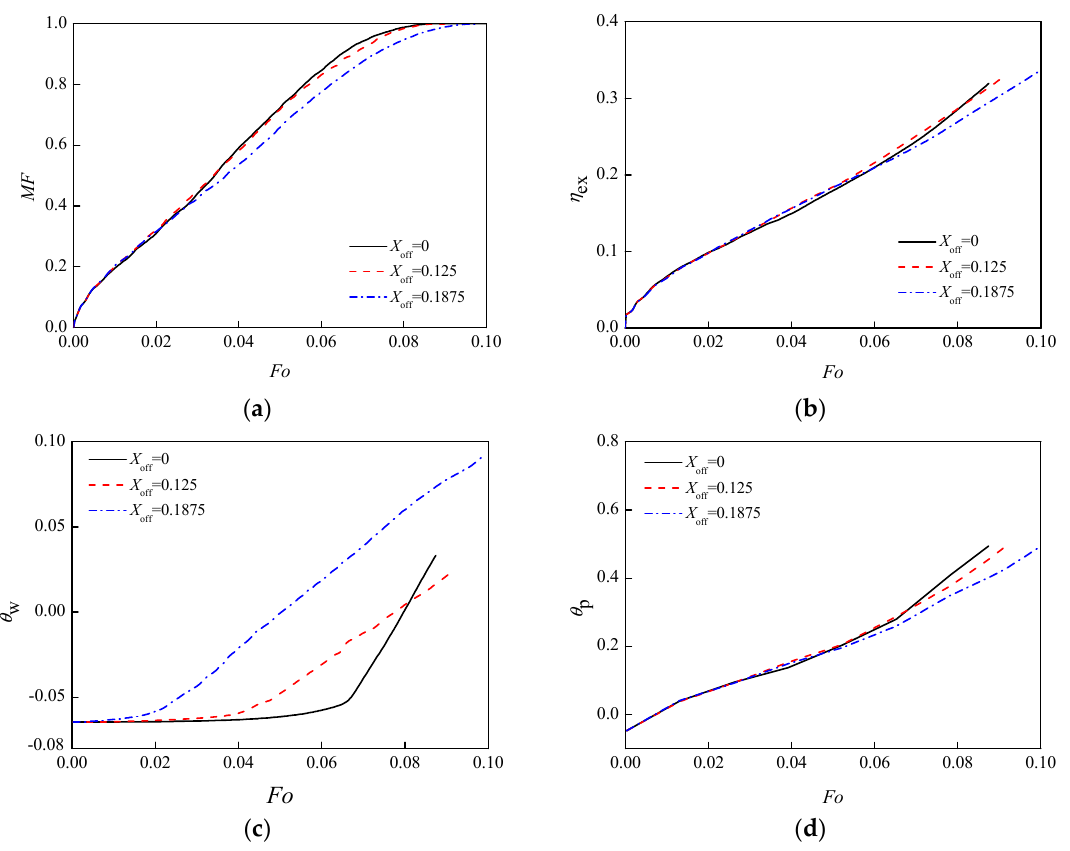
Figure 5. Evolution of the performance parameters for varying eccentricity: ( a ) melting fraction; ( b )